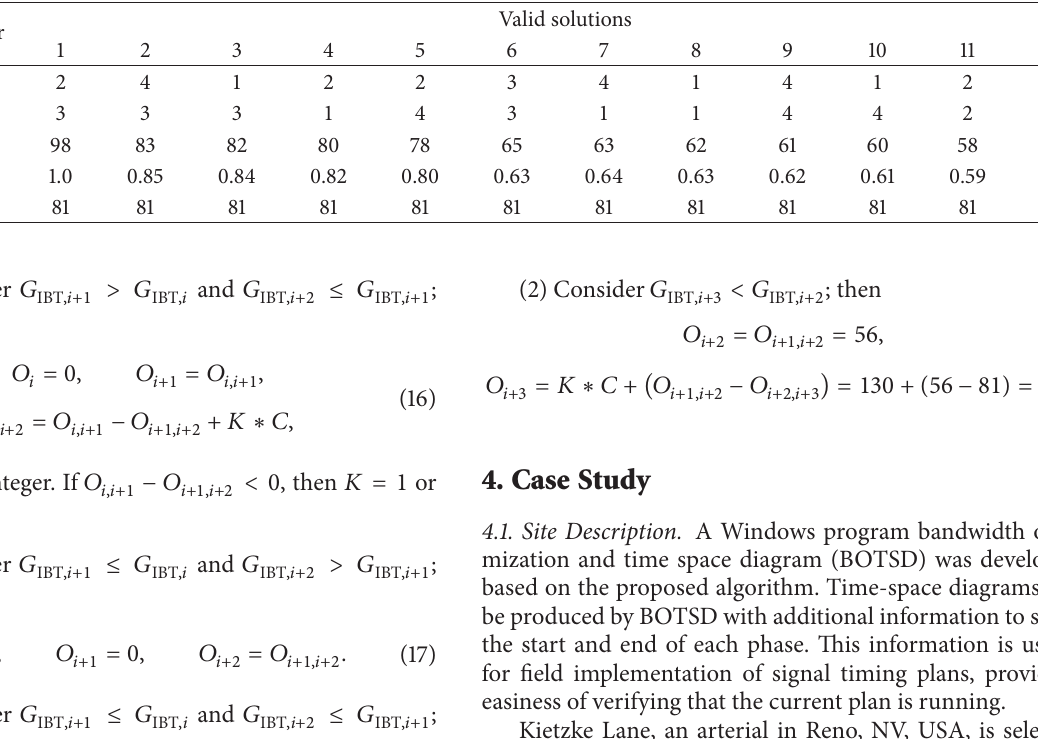
< 𝐺 , Vassar Street and Plumb IBT ,𝑖+3 IBT ,𝑖+2